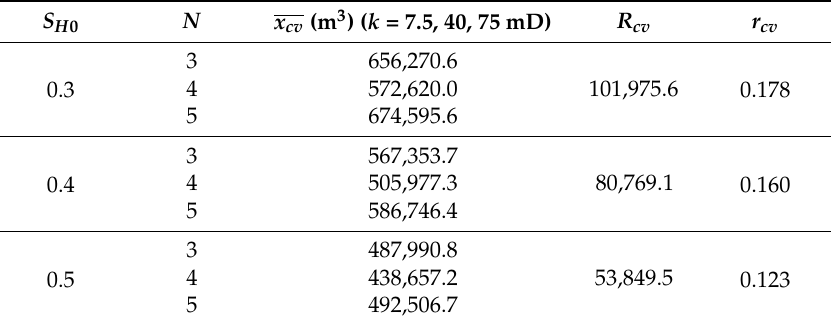
Table 10. Range analysis of Q cv for varying N in different S H 0